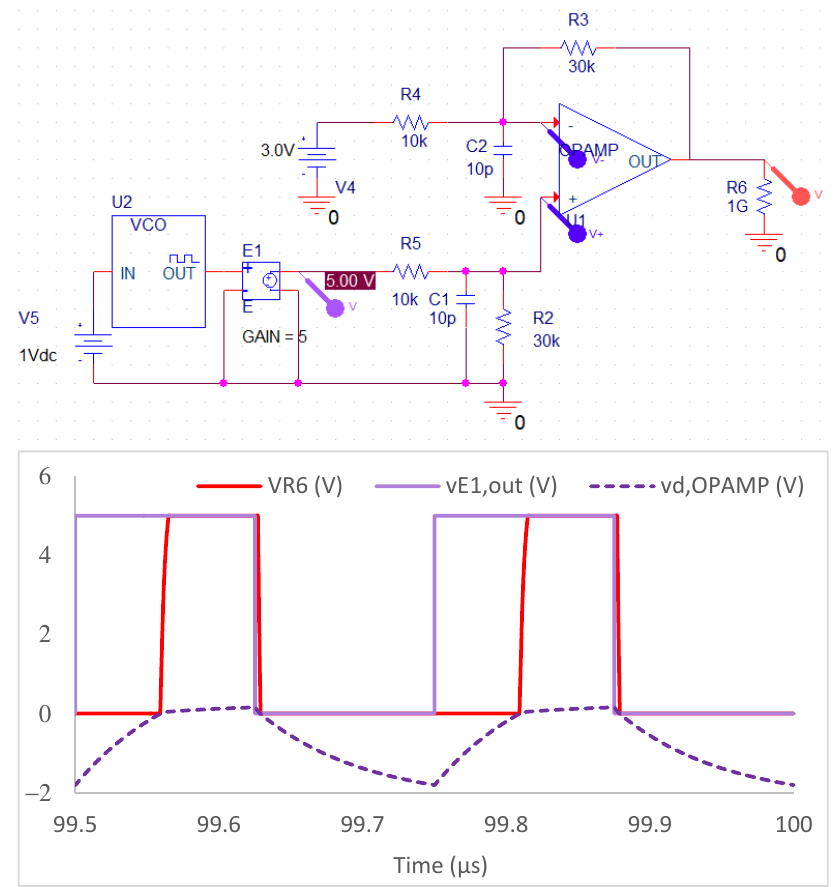
Figure 16. SPICE analysis of VFPWM using a high-resistance cCCDA in series with a VCO.